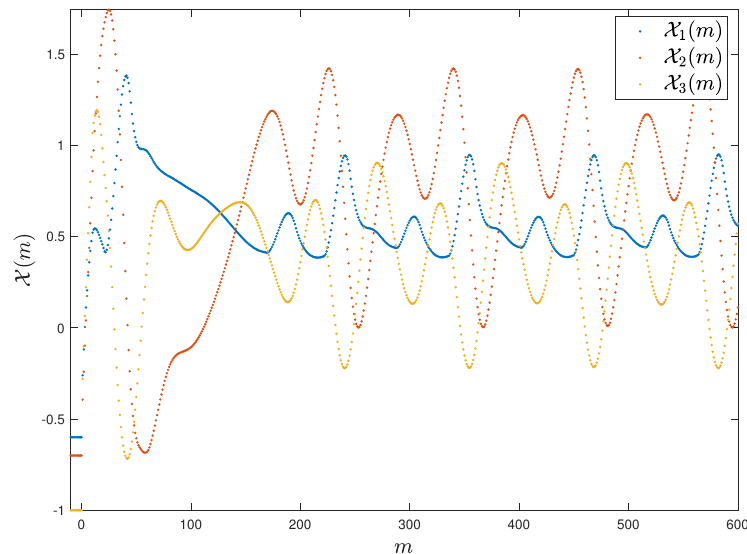
Figure 3. X ( m ) of system (37) for m ∈ [ − 10,600 ] .